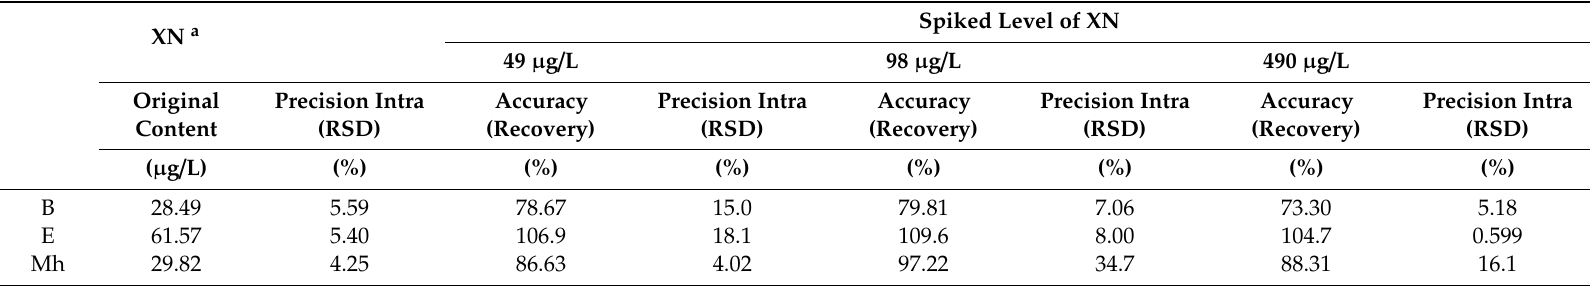
Table 6. Recoveries and precision of the solid-phase extraction (SPE)-HPLC-DAD method in di ff erent commercial beers at three concentration levels of XN ( n = 3). XN